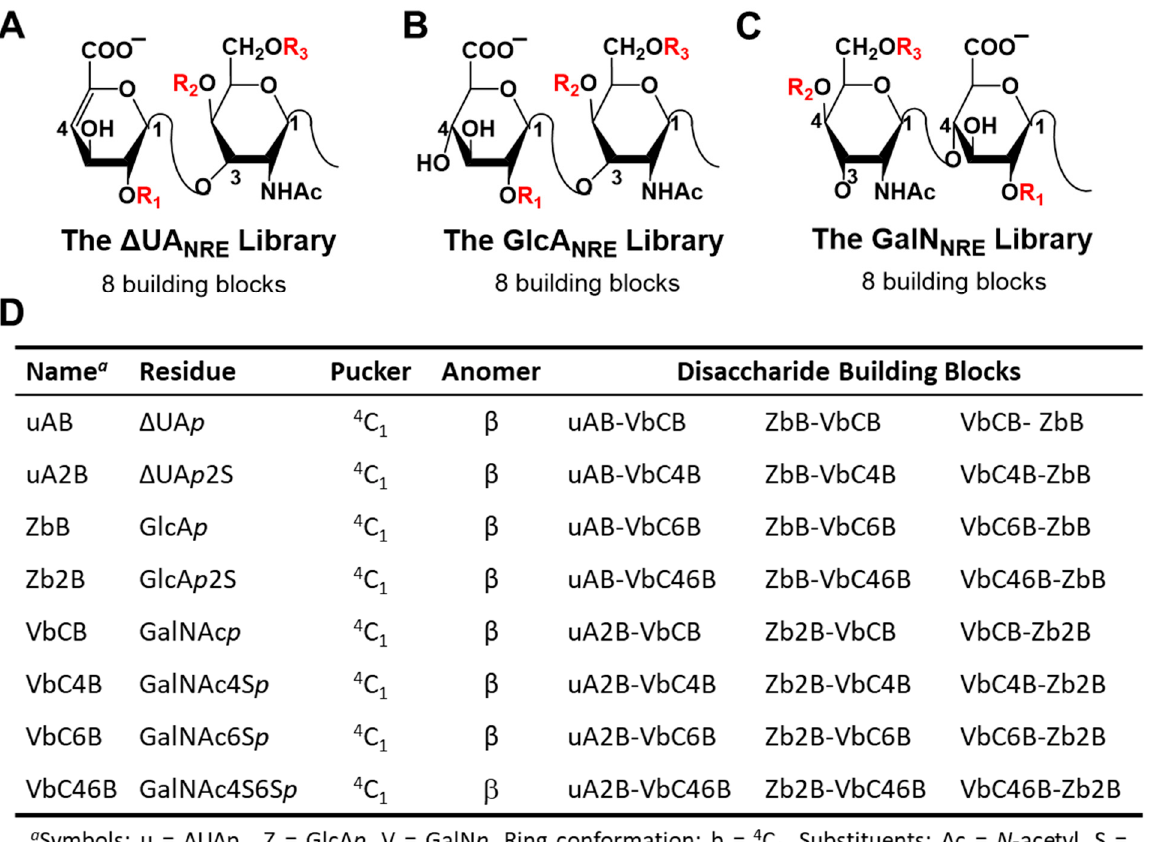
Figure 10. The chondroitin sulfate (CS) disaccharide building blocks and their naming conventions: ( A ) the ∆ UA NRE library of oligosaccharides (di- to hexasaccharide) has an unsaturated uronic acid residue at the non-reducing end (NRE) and a GalN p residue at the reducing end; ( B ) the GlcA NRE library has a GlcA p residue at the NRE, and ( C ) the GalN NRE library has a GalN p residue at the NRE; ( D ) the list of monomer residues and the R 1 , R 2 , and R 3 variations for ∆ UA p , GlcA p, and GalN p considered in this study. These variations lead to 24 disaccharide building blocks. Table 4. Average torsion across the 1 → 3 and 1 → 4 inter-glycosidic bonds used in CVLS.